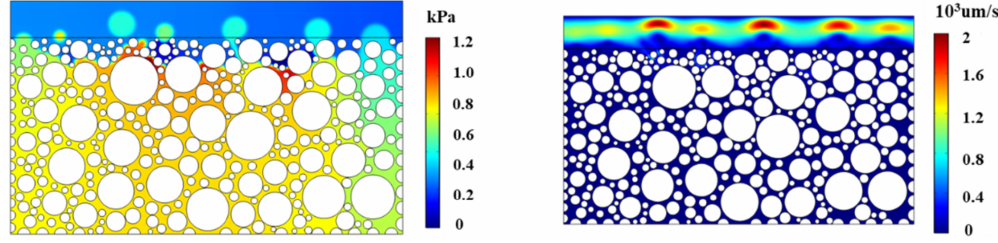
Figure 14. ( a ) Pressure distribution at t D = 0.0481. ( b ) Velocity distribution at t D =